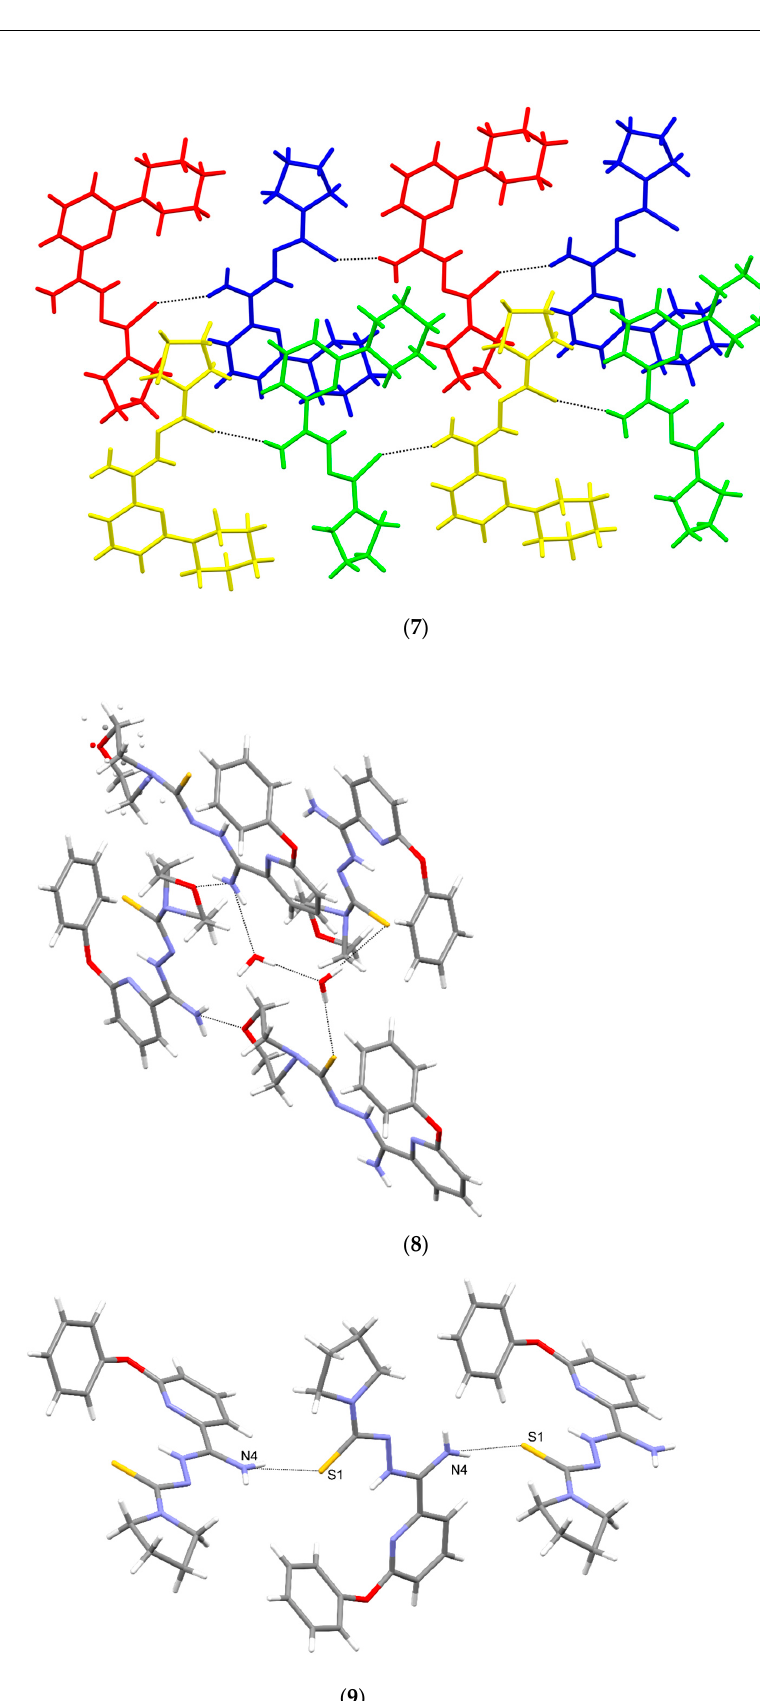
Figure 4. Intermolecular hydrogen bonds in 4 – 9 .